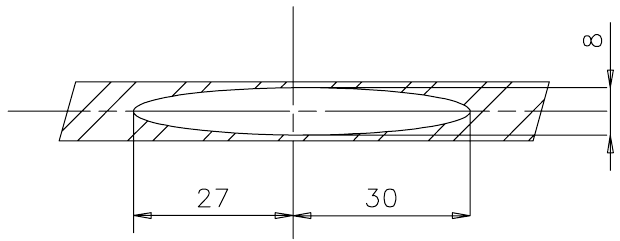
FIG. 3. Cross section of a 5 m long chamber of an aperture of 8 mm in an ID section.